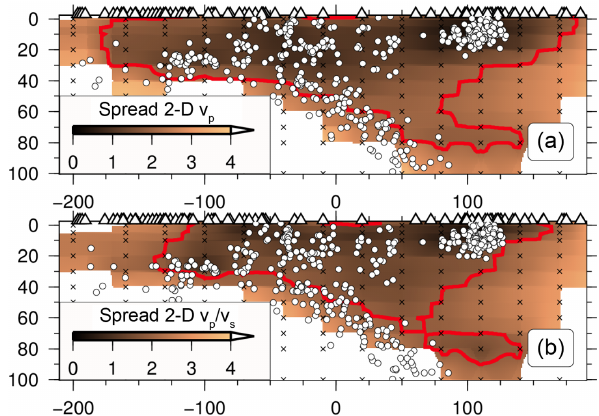
Figure 4. Spread values of 2-D v p (a) and v p /v s (b) inversion. Re- gions with low spread values and thus good resolution (selection of a cut-off spread value based on analysis of the model resolution ma- trix and synthetic tests) are encircled with a red line. Cut-off spread values are 2.1 and 1.9 for v p and v p /v s , respectively. Circles indi- cate hypocenters and grid nodes are shown with crosses. Stations are indicated with